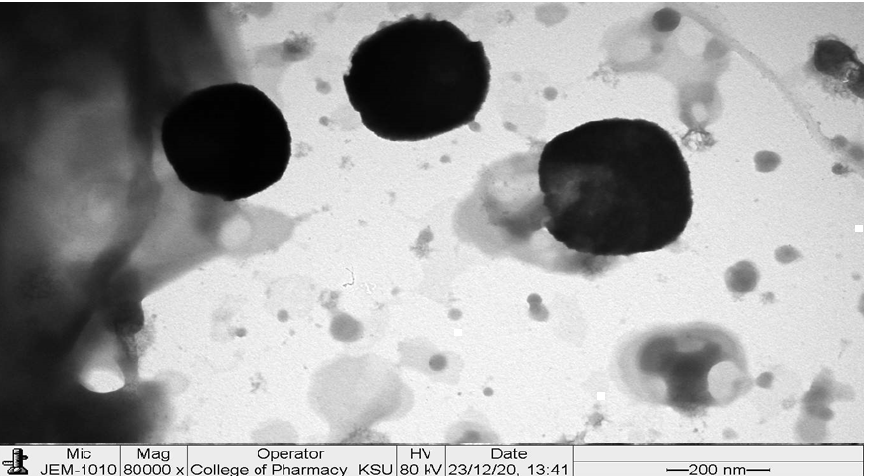
Figure 6. TEM image of the optimized formula.